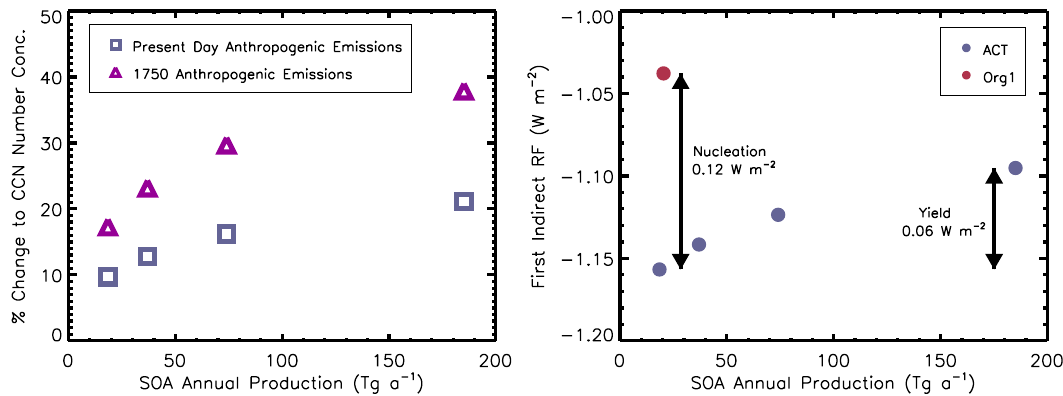
Fig. 11. Left: percentage change to global annual mean CCN concentration when biogenic SOA is included, simulated using the ACT nucle- ation mechanism at four different SOA production yields, with present-day (squares) and pre-industrial (triangles) anthropogenic emissions. Right: anthropogenic first aerosol indirect RF from 1750 to present-day, simulated using the ACT nucleation mechanism at four different yields for SOA production (purple circles), and using the Org1 nucleation mechanism with standard SOA production yield (red circle). Arrows highlight the RF sensitivity to assumptions about SOA yield and nucleation